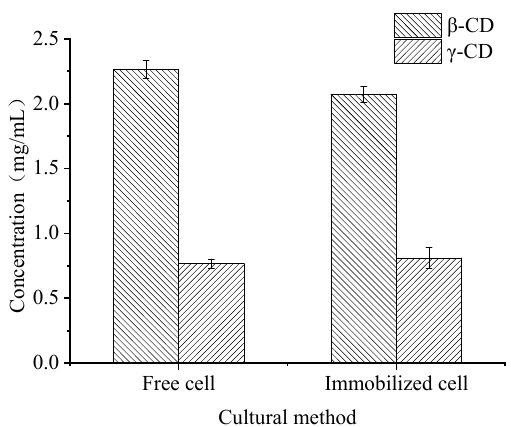
Figure 2. Cyclodextrin production by free and palm curtain immobilized Bacillus circulans ATCC 21783.